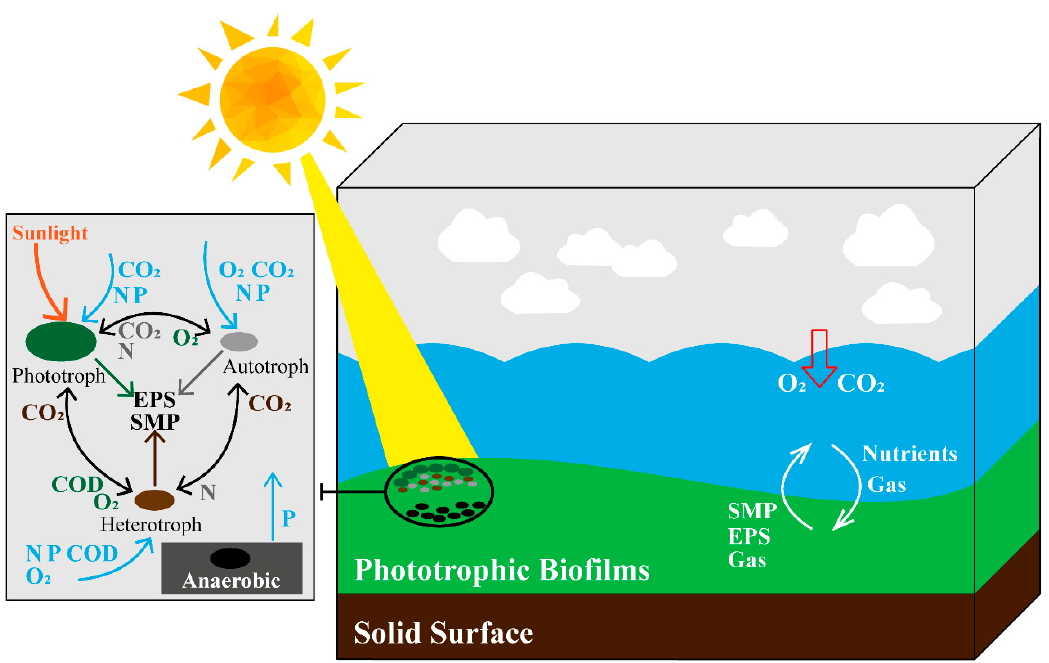
Figure 6. The interaction mechanisms between the phototrophic biofilms and micro-polluted source water. SMP: soluble microbial products; EPS: extracellular polymeric substance.